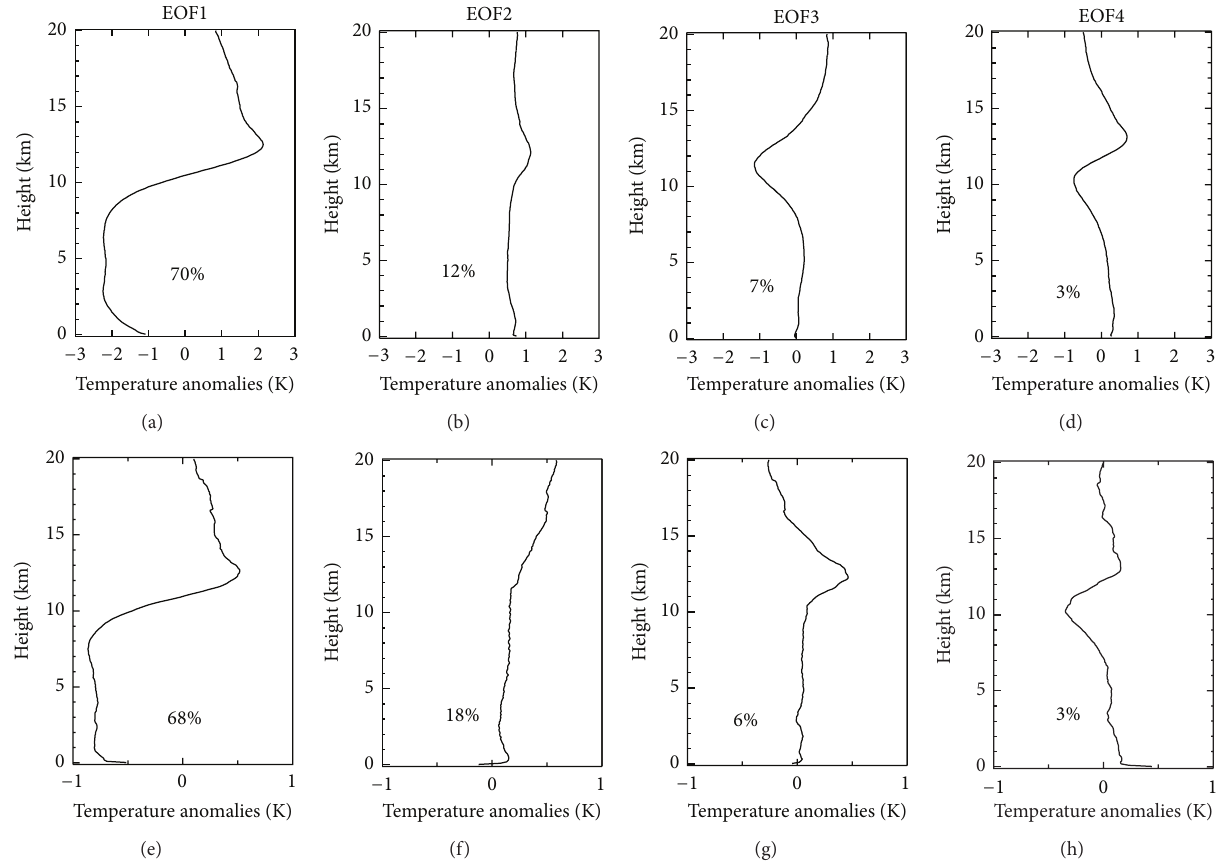
Figure 4: The first four EOFs evaluated for the matrix F 1 (intra-annual variations, up) and F 2 (interannual variations, down). The corresponding weight 𝑤 𝑗 of each component, evaluated through (3), is given in each